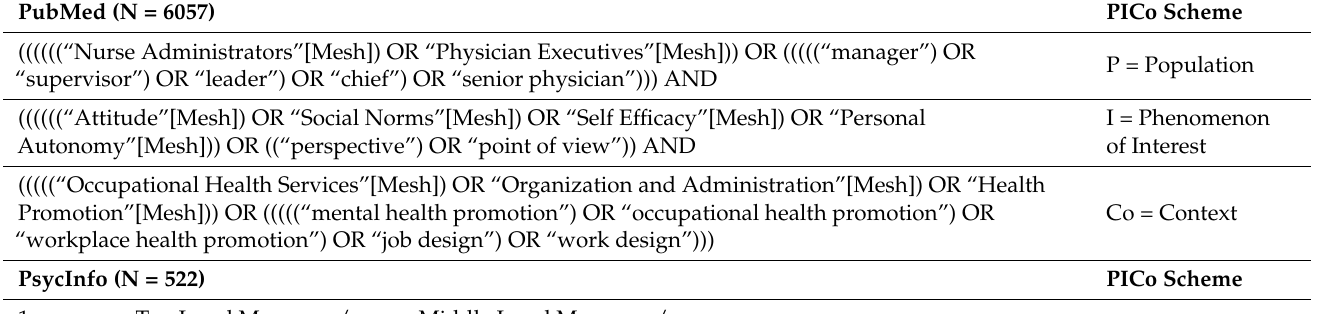
Table A1. Electronic search algorithms for systematic